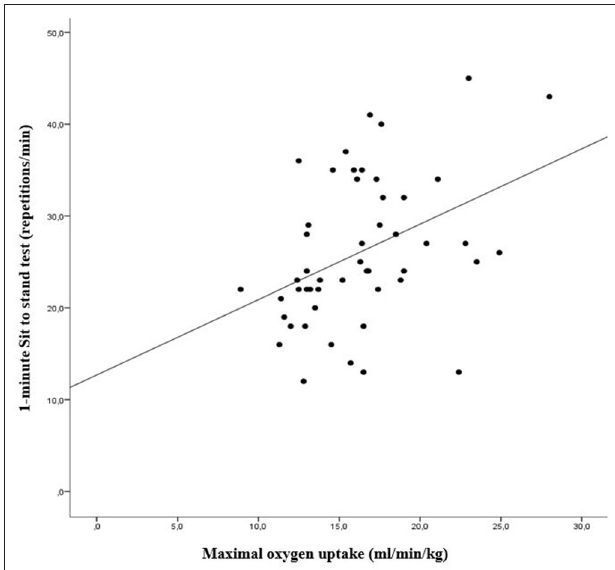
FIGURE 1 | The relationship between matrix maximal oxygen uptake (V’O 2 max) measured during the exercise test and 1-minute Sit to Stand test repetitions (1MSTS) by level exercise capacity (linear regression modeling). Pearson correlation coefficient for all samples: [ r = 0.401 (95% CI 0.114–0.625)] correlation formula: ( y = 12.69 + 0.82 x ) with y = 1MSTS repetitions and x = V’O 2 max) (For normal exercise capacities: [ r = 0.027 (95% CI − 0.348 to 0.460)], and for decreased exercise capacities [ r = 0.569 (95% CI